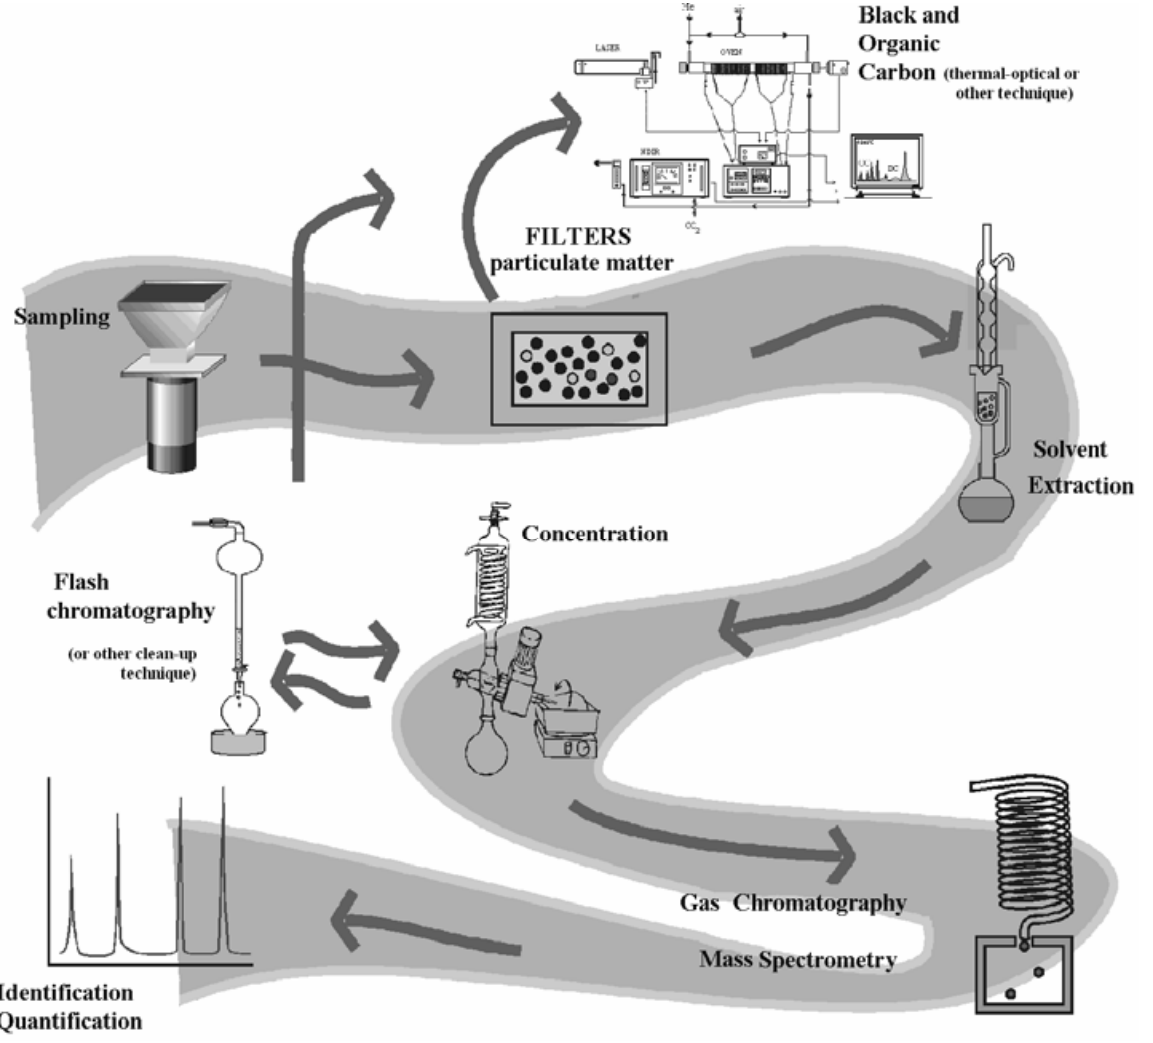
Fig. 1 – Scheme representing a common sampling, extraction and GC/MS procedure for organic speciation of atmospheric